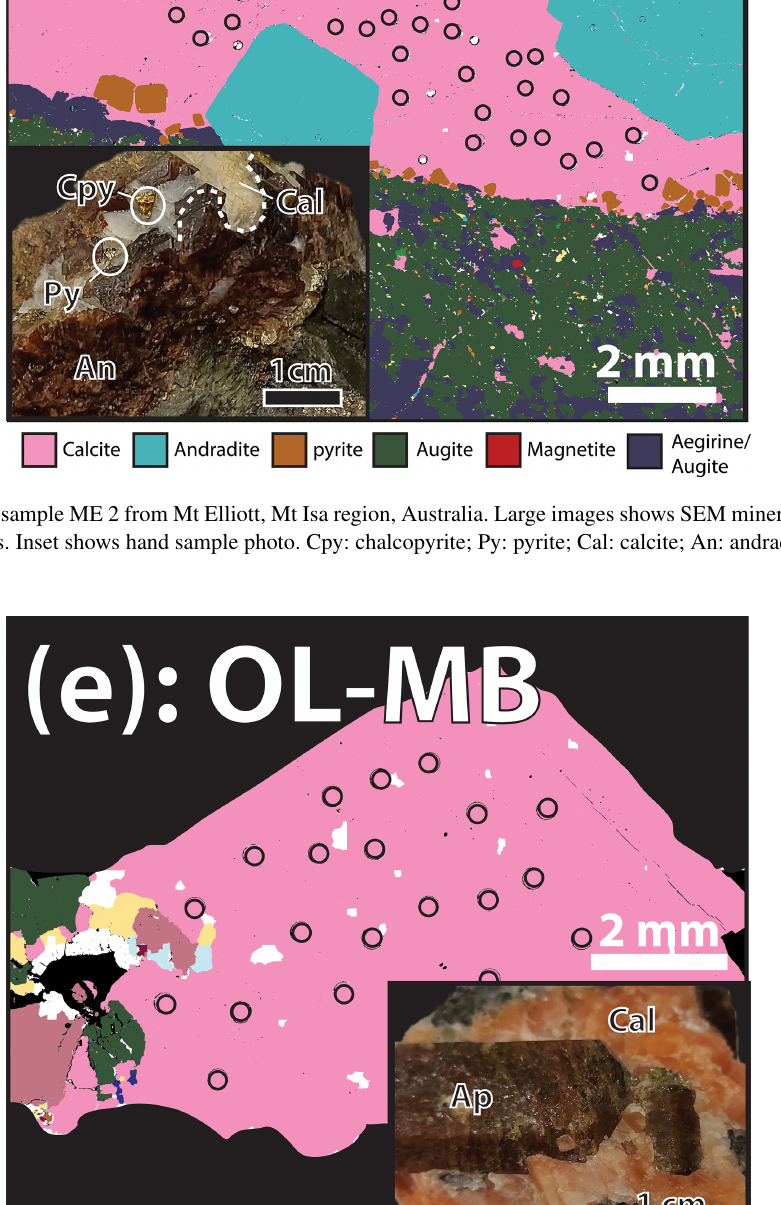
Geochronology, 4, 353–372, 2022